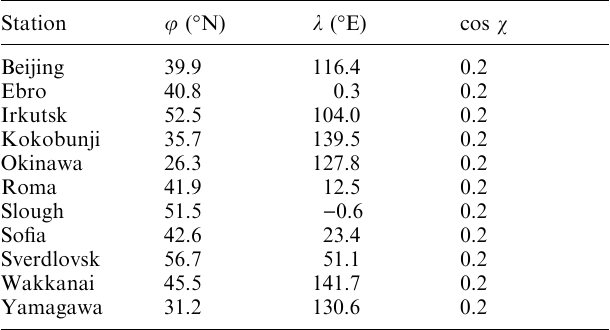
Table 2. List of f measurements used, name of station, latitude min ( u ) and longitude ( k ), the constant solar zenith angle (cos v )